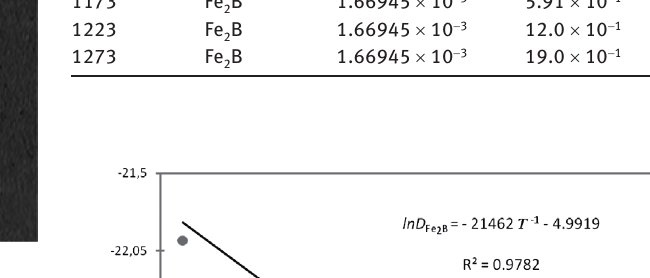
Fig. 8: SEM micrograph showing the indentation of VDI cohesion test on the surface of AISI 1026 steel borided at 1273 K for 4 h.